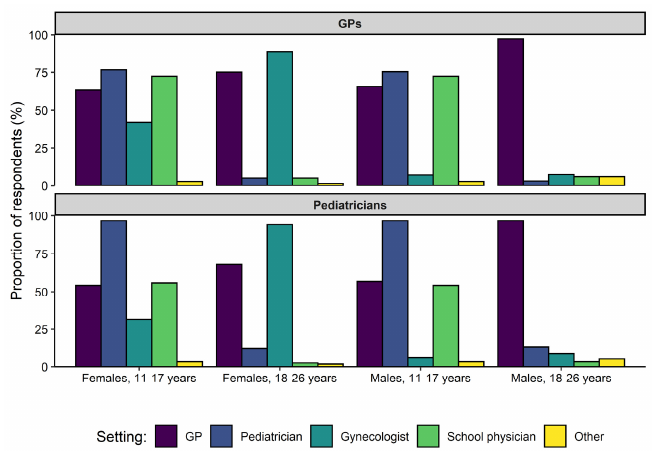
Figure 3. Evaluation of various clinical settings in the context of human papillomavirus (HPV) vaccine administration. For this item, respondents were asked to select the clinical settings they deemed to pose the greatest opportunity to reach four different age and gender groups for HPV vaccination (multiple choice). Abbreviations: general practitioner (GP). Table 1. Demographic and professional characteristics of included survey respondents ( n = 422). Abbreviations: general practitioner (GP); interquartile range (IQR); human papillomavirus (HPV).